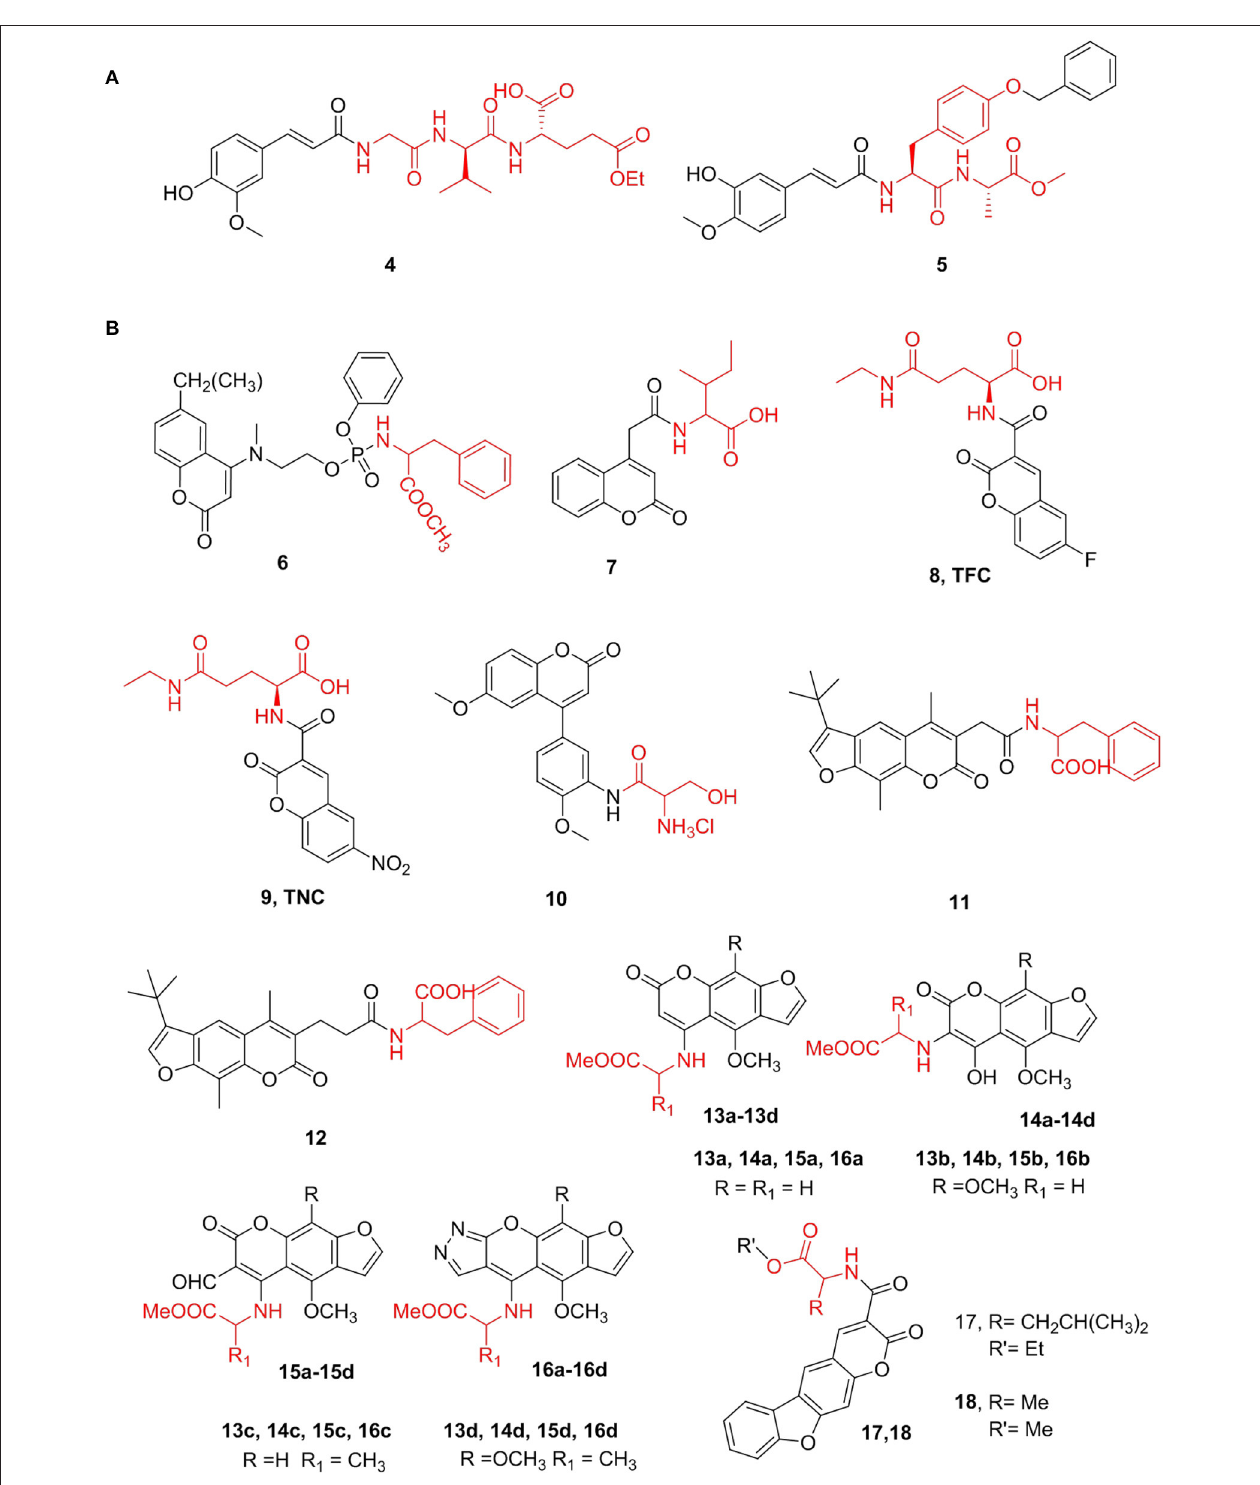
FIGURE 2 | (A) Cinnamic acid derivatives. (B) Coumarins amino acid derivatives.